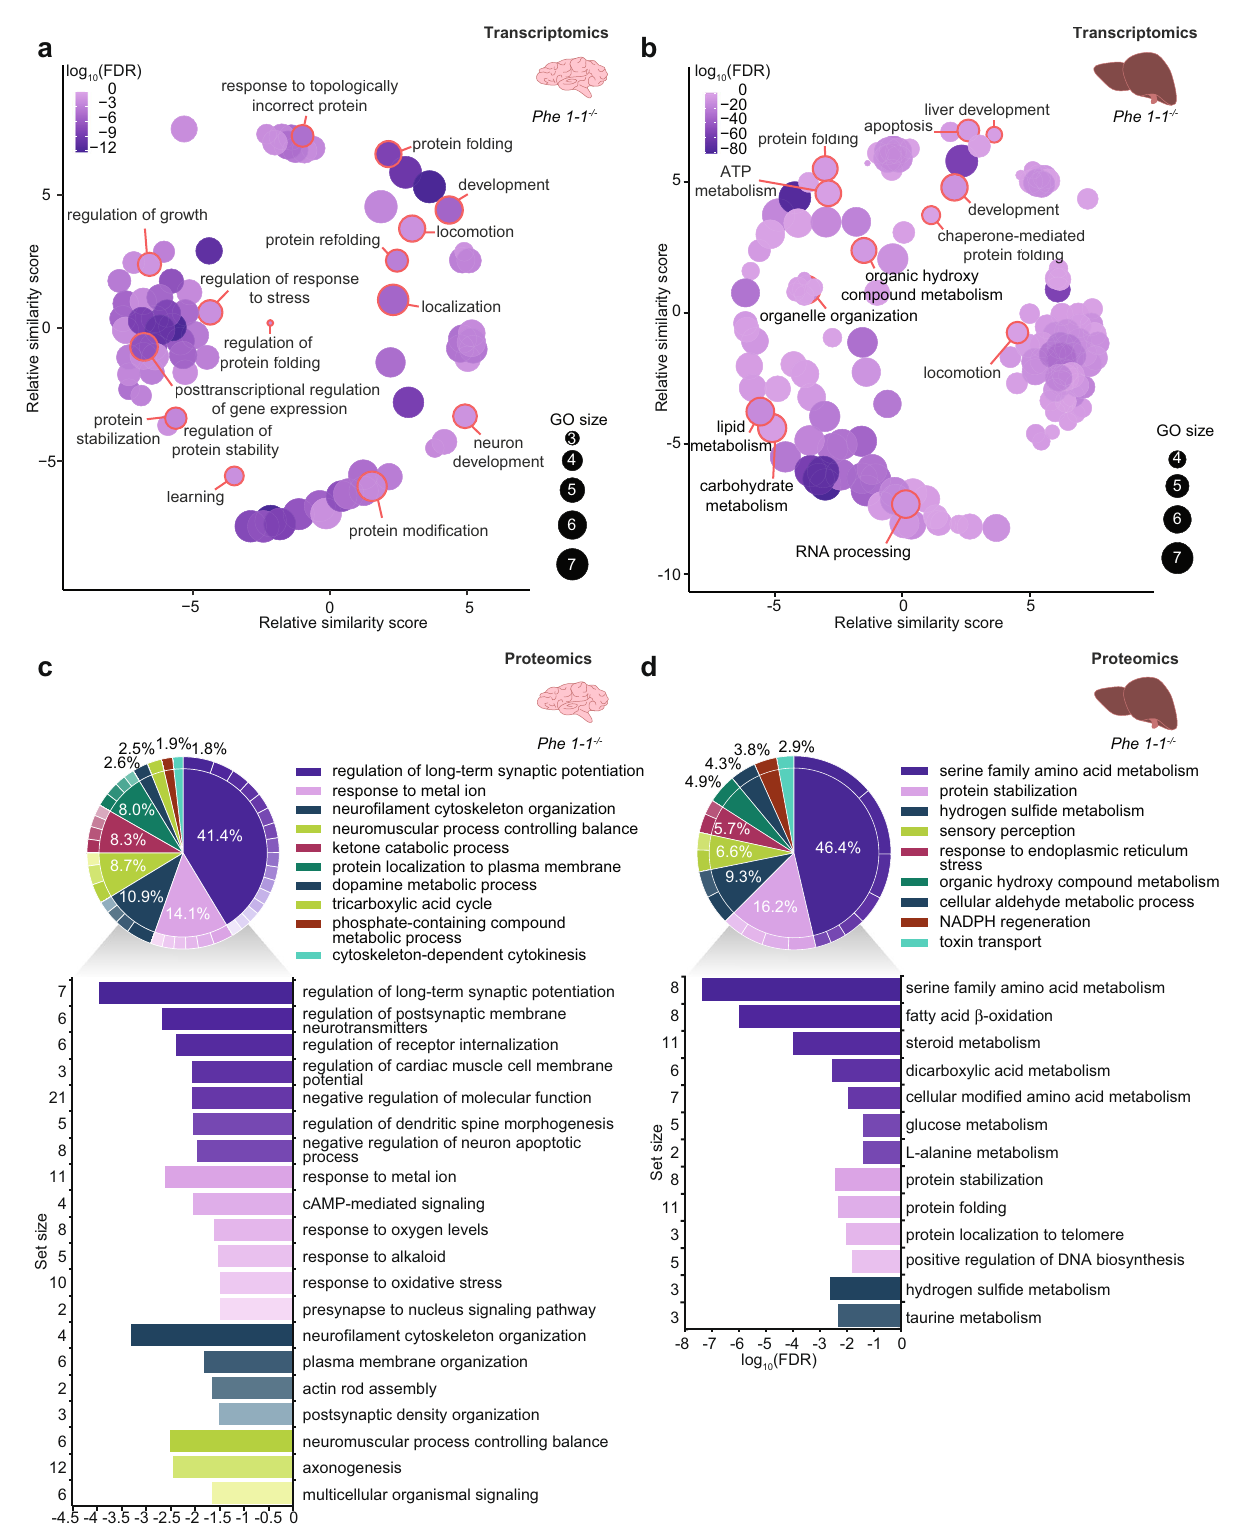
proteomic analyses, we performed toluidine-blue staining of sagittal brain sections in mice lacking this tRNA and compared them to the tRNA-Phe-2-1 -/- , tRNA-Phe-3-1 -/- and wild-type mice. We observed no structural changes in the cortex, hippocampus or cerebellum of knockout mice compared to controls (Fig. 4a – d), indicating that by 10 weeks the tRNA-Phe-1-1 knockout had not caused gross changes in